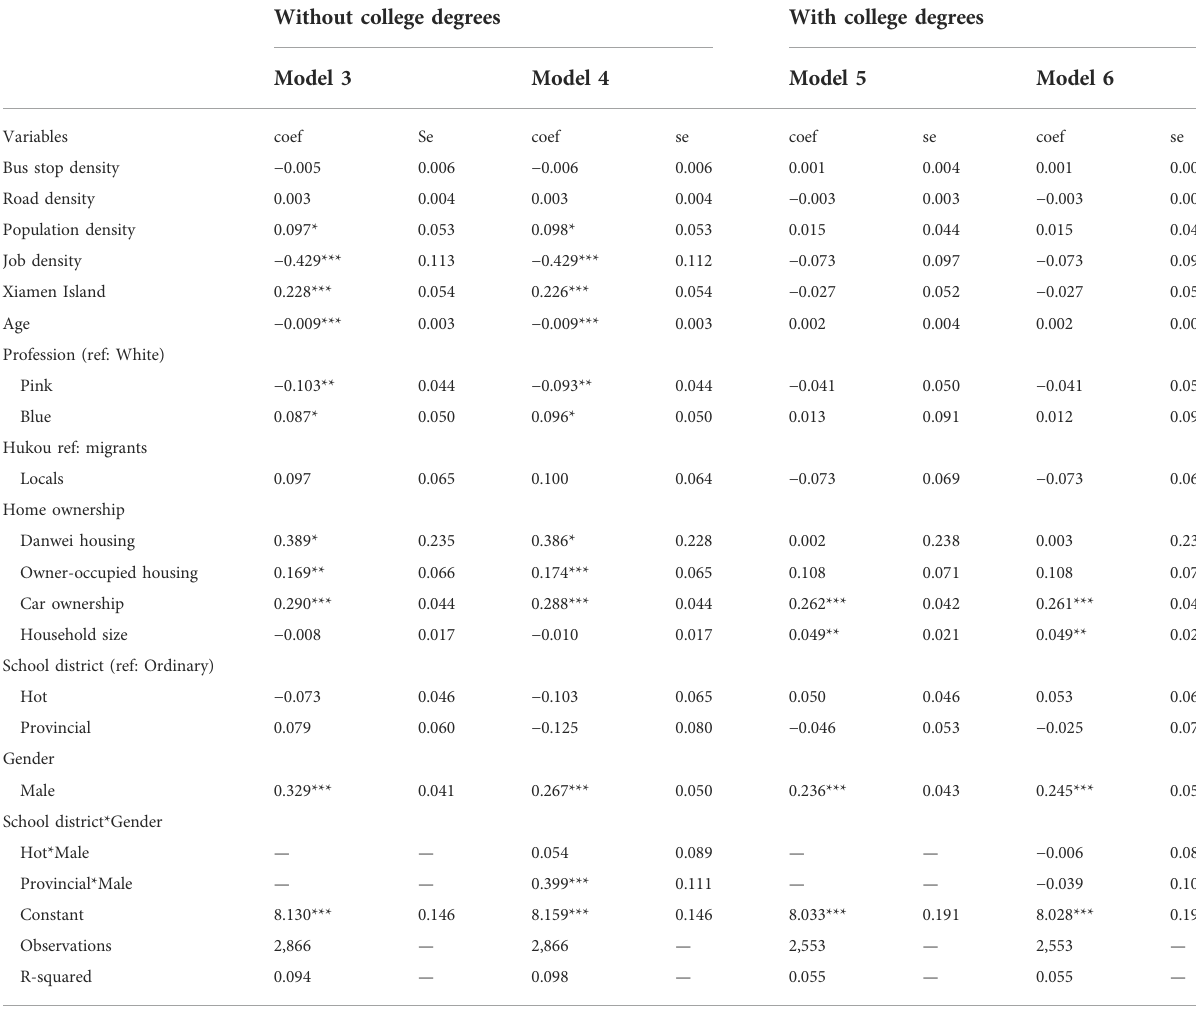
TABLE 4 Regression of the natural logarithm of the commuting distance for respondents without/with college degrees.